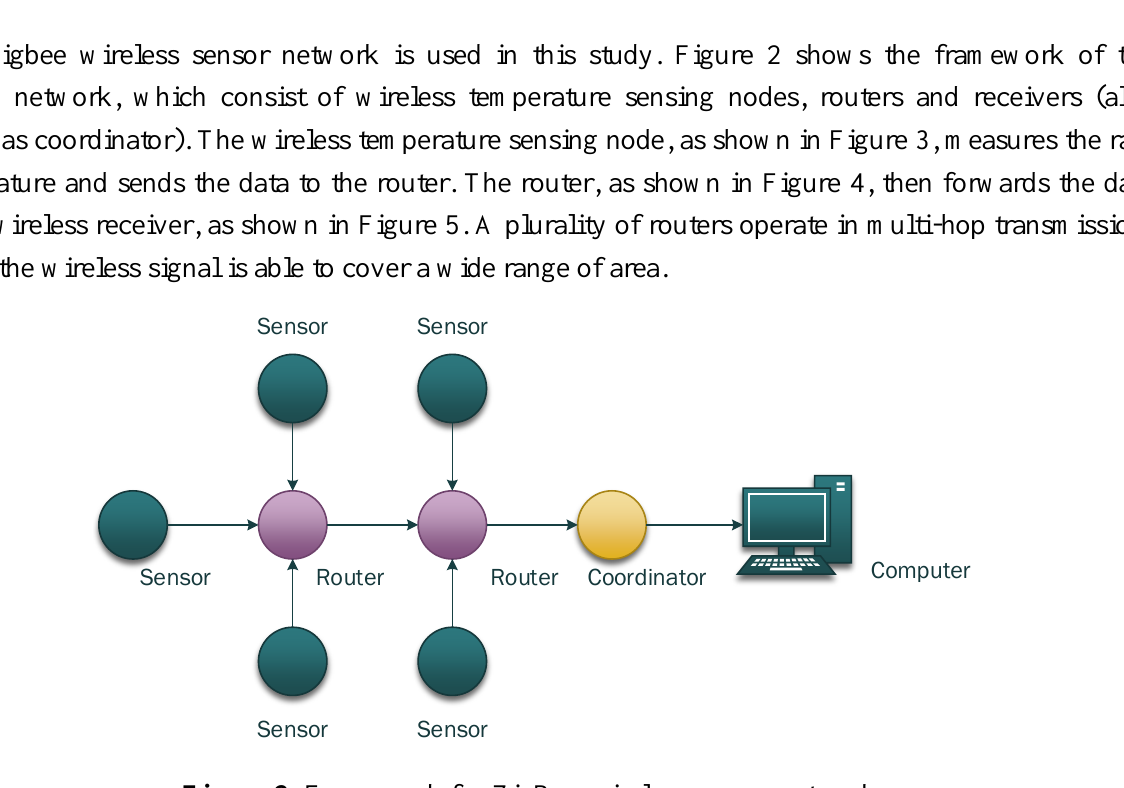
Figure 2. Framework for ZigBee wireless sensor network.